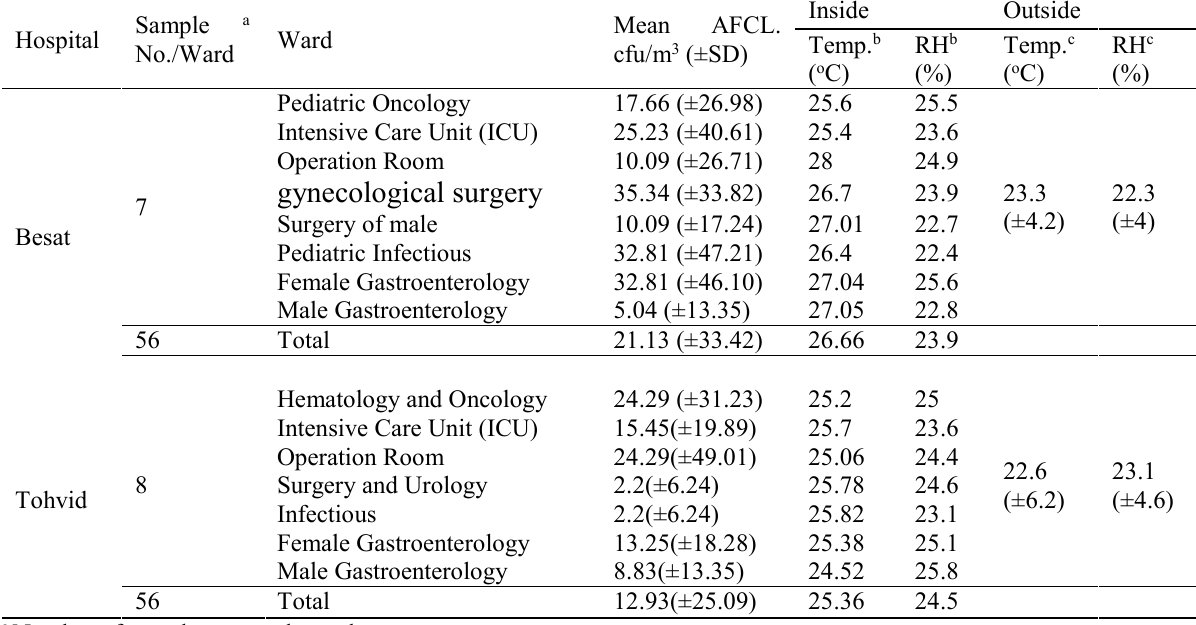
Table 1. Air fungal contamination load (AFCL) in cfu/m 3 in various wards and conditions Hospital